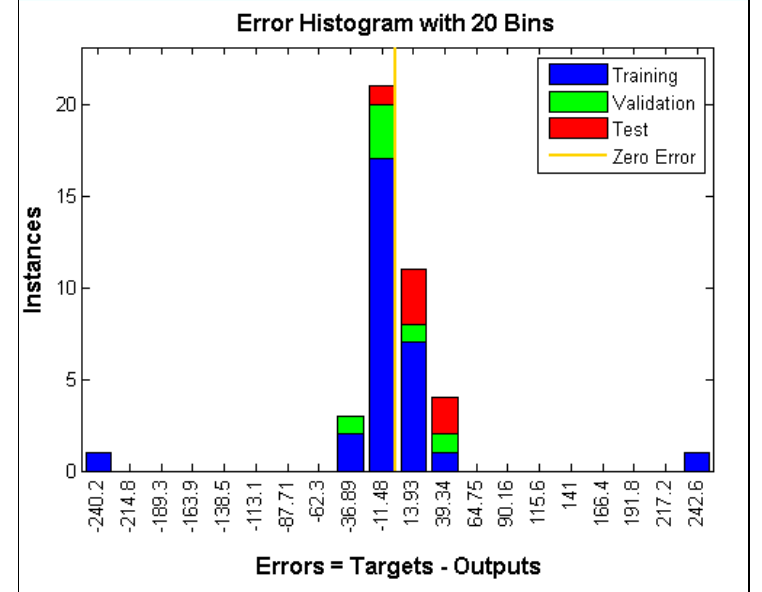
Figure 5. Investigation of the resulting error values between the experimental results and what predicted by the neural network (X-axis: number of samples, Y-axis, error